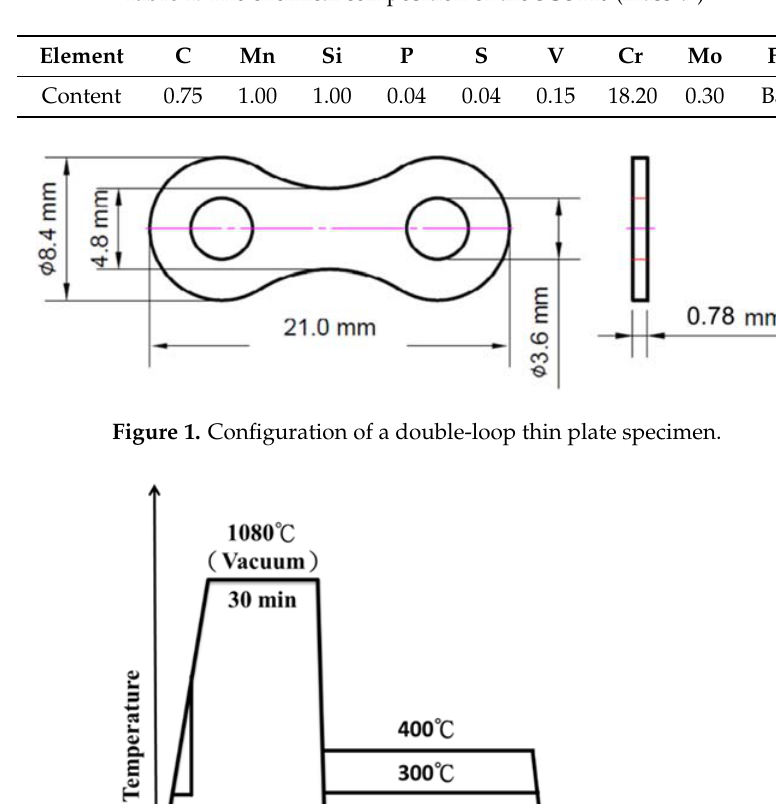
Table 1. The chemical composition of the SUS440 (mass %).